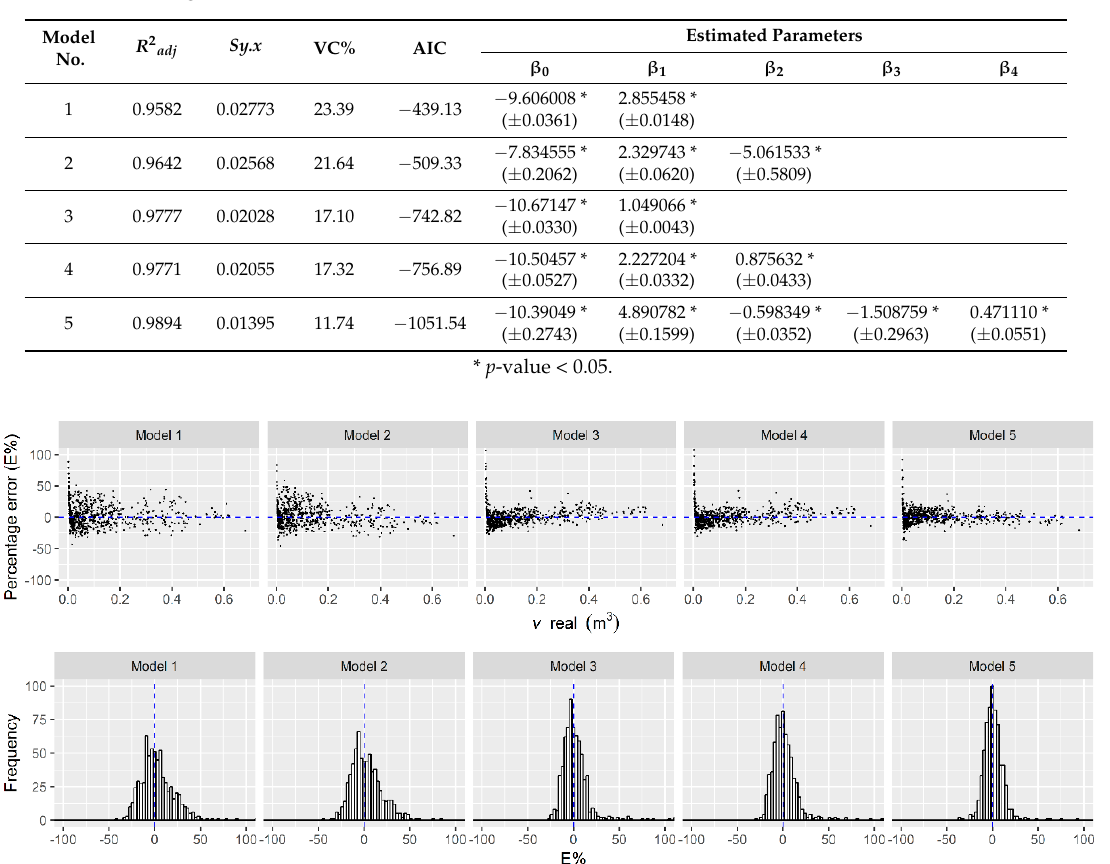
Table 3. Adjusted coefficient of determination ( R 2 adj ), residual standard error ( S y.x , in m 3 ), variation coefficient (VC%), Akaike’s Information Criterion (AIC), and parameters estimated (and standard errors) with significance in the t -test for the fitted models.